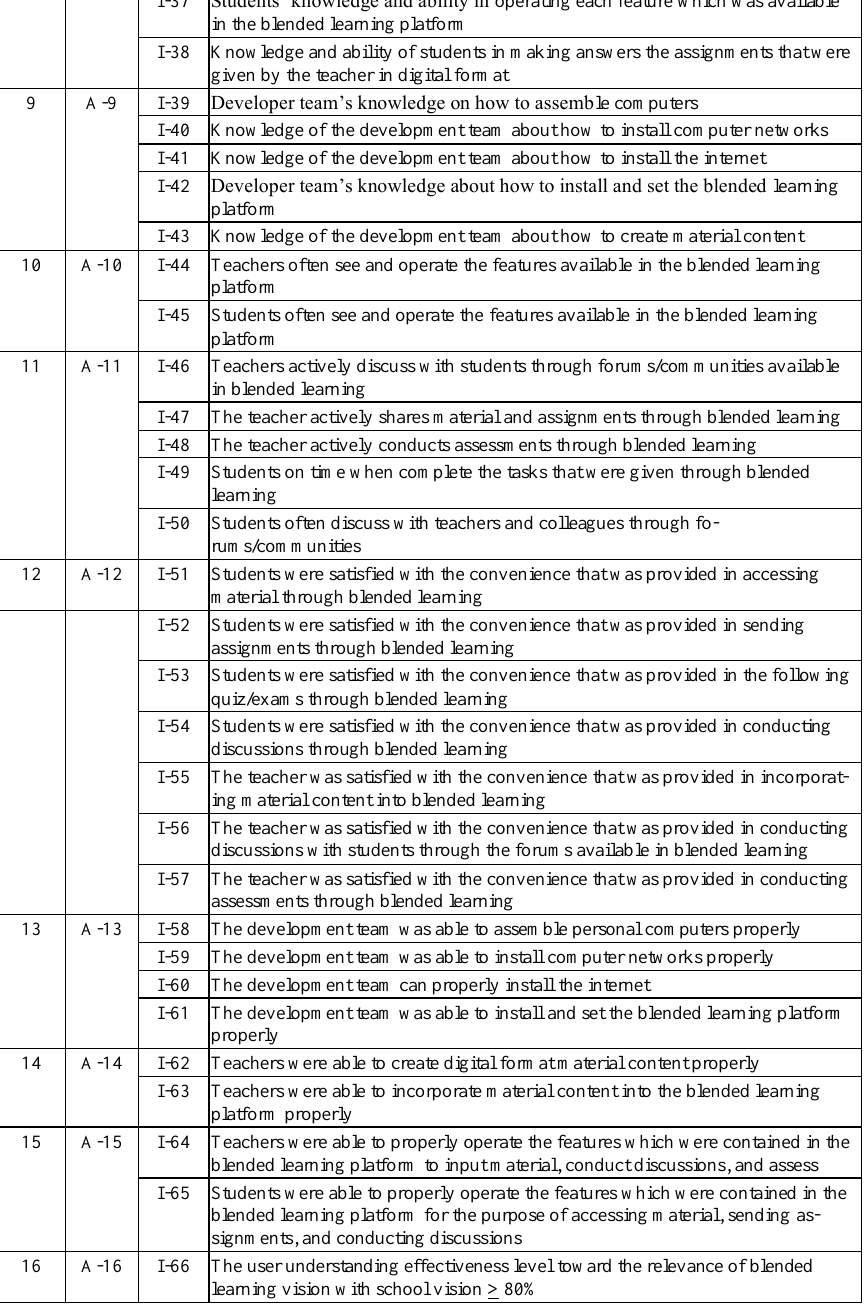
Paper — Instruments Development of Tri Kaya Parisudha-Based Countenance Model in